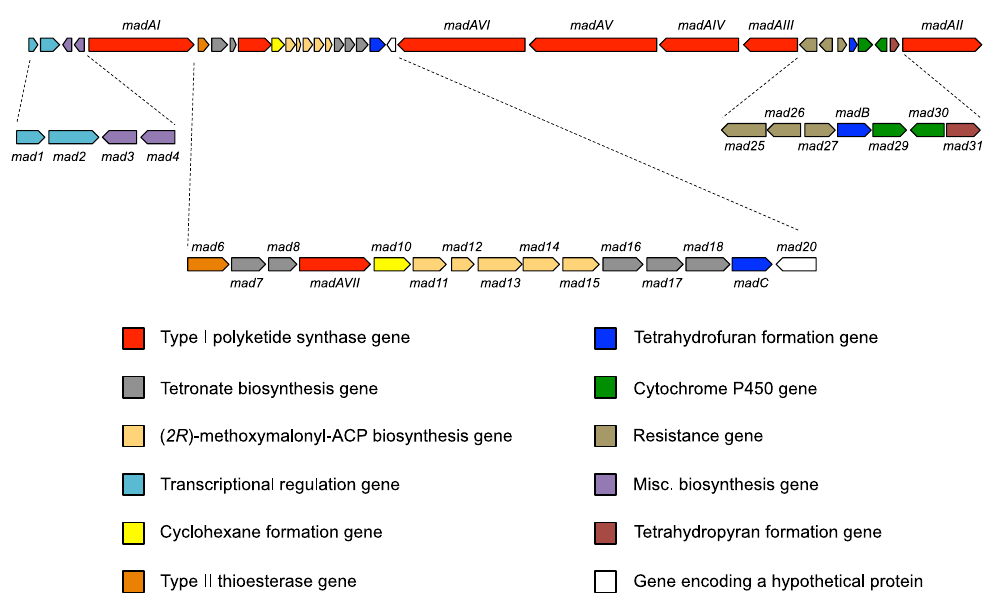
Fig 3. The tetromadurin biosynthetic gene cluster (the mad gene cluster). The total size of the mad gene cluster is 110 kbp. A total of 32 were predicted to comprise the mad gene cluster. Genes are colour coded according to their predicted